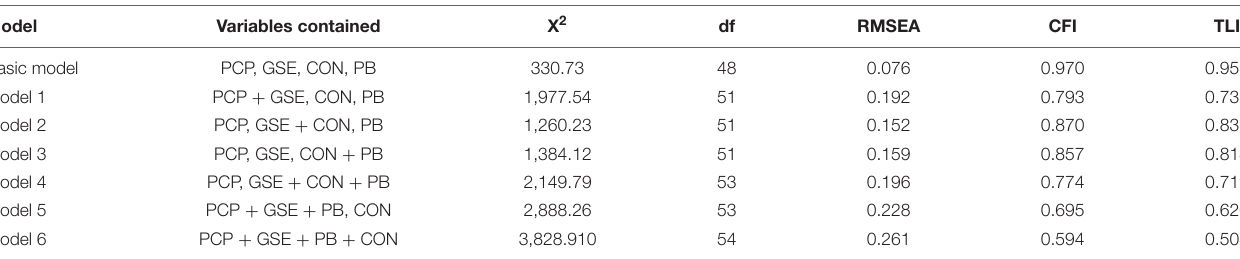
TABLE 2 | Confirmatory factor analysis of discriminant